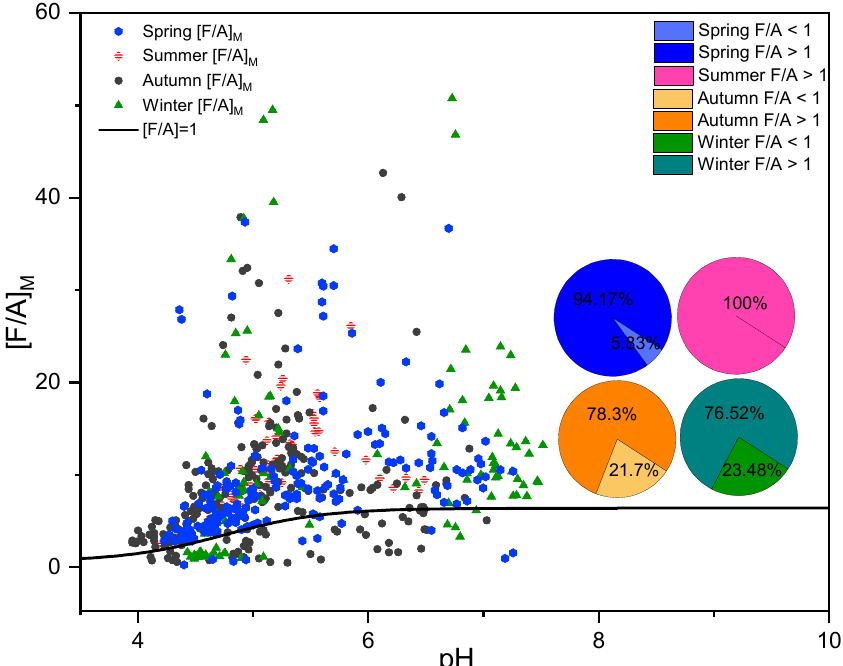
Figure 6. The [F/A] M judgment equation curve and [F/A] M of rainfall events for Spring, Summer, Autumn, and Winter. The proportion [F/A] M > 1 in each season is represented in pie charts.